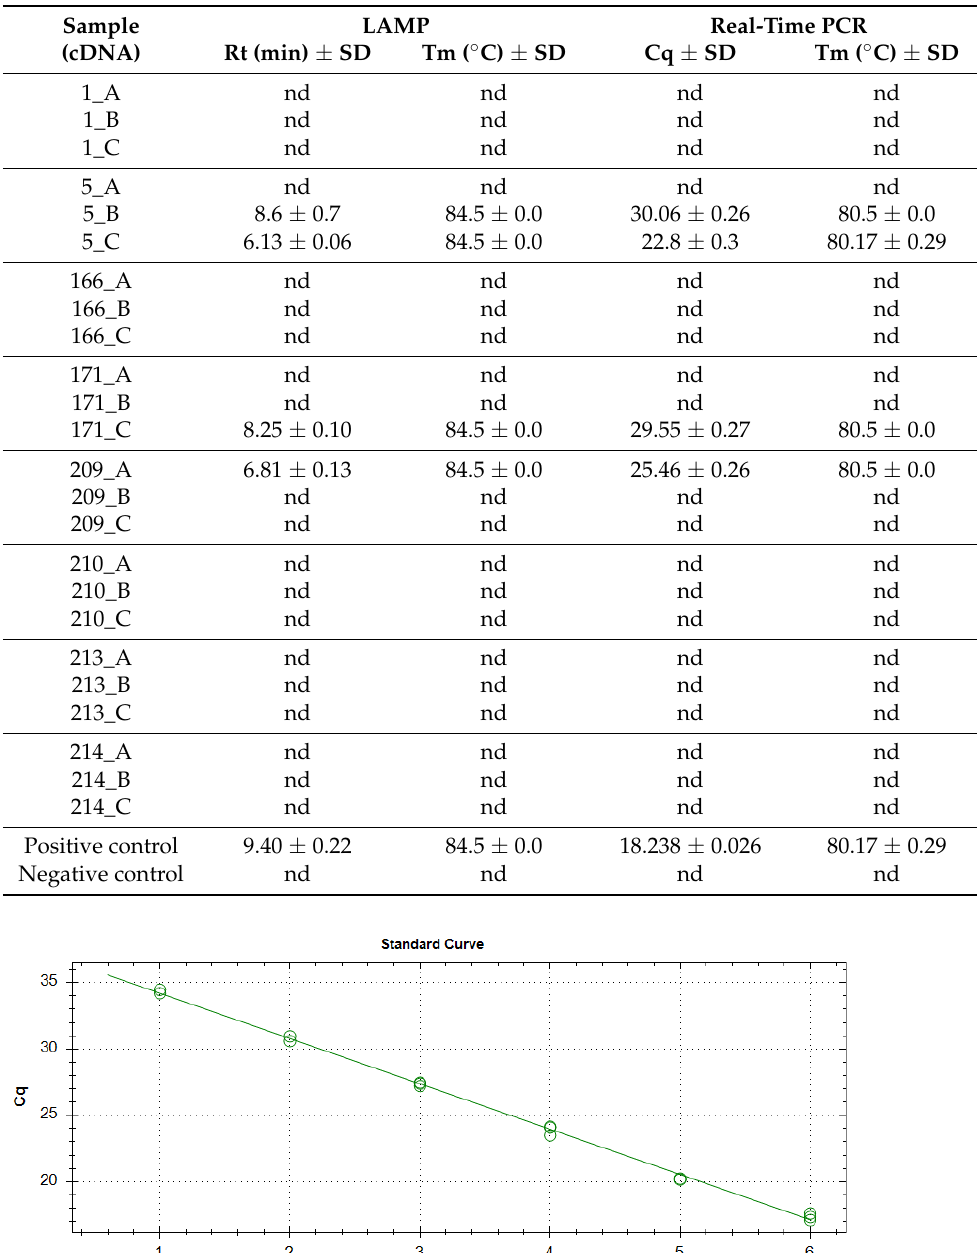
Table 4. Comparison between LAMP and real-time PCR performed on cDNAs (10 − 5 dilution) of leaf samples from durum wheat grown in virus-infected soil. Experiment performed in the CFX instrument. Rt: reaction time; Tm: melting temperature; Cq: threshold cycle; SD: standard deviation; nd: not detected.